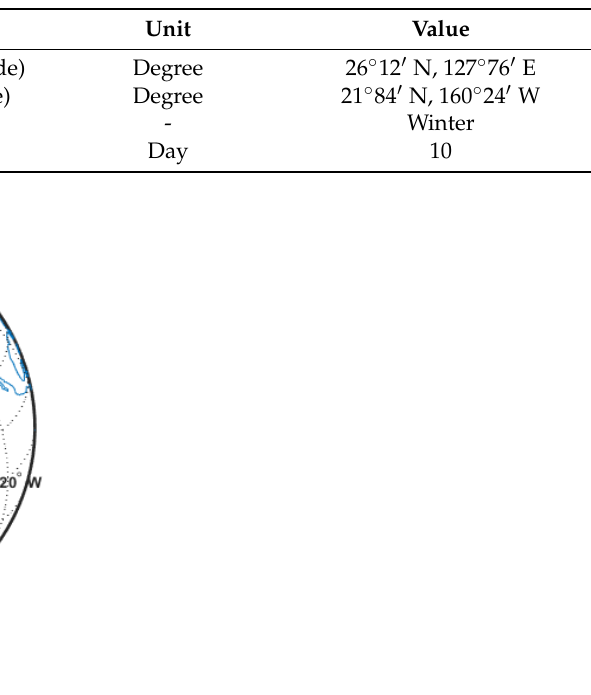
Table 7. The Pacific route conditions.